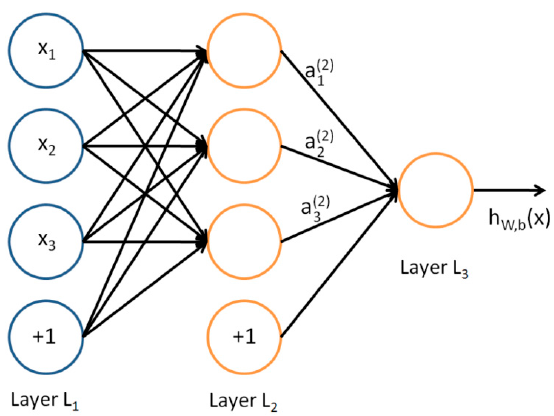
Figure 4. Part of the DNN network.